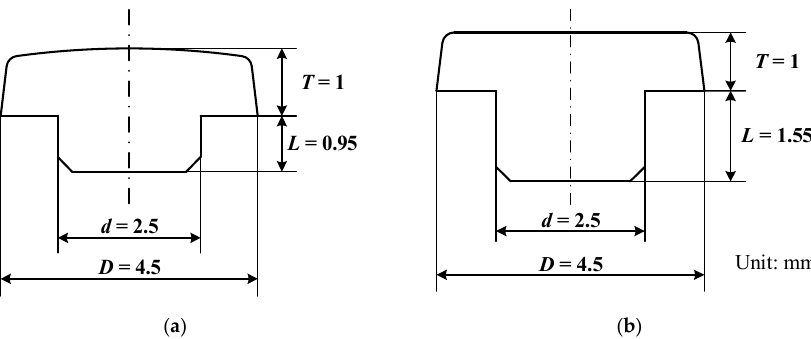
Figure 4. The sizes of the electrodes. ( a ) Movable sample. ( b ) Static sample.